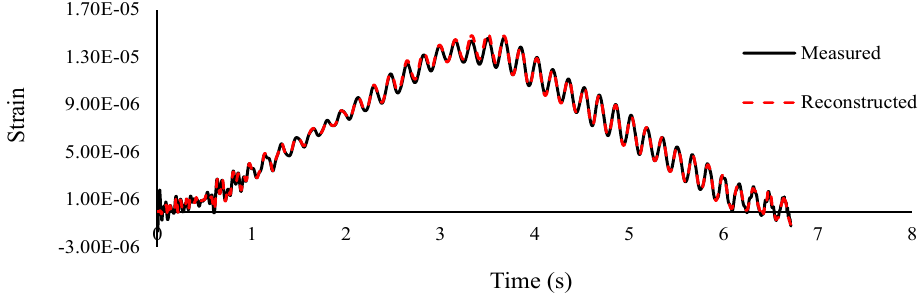
Figure 18. The effect of N f on the error of the reconstructed strain.